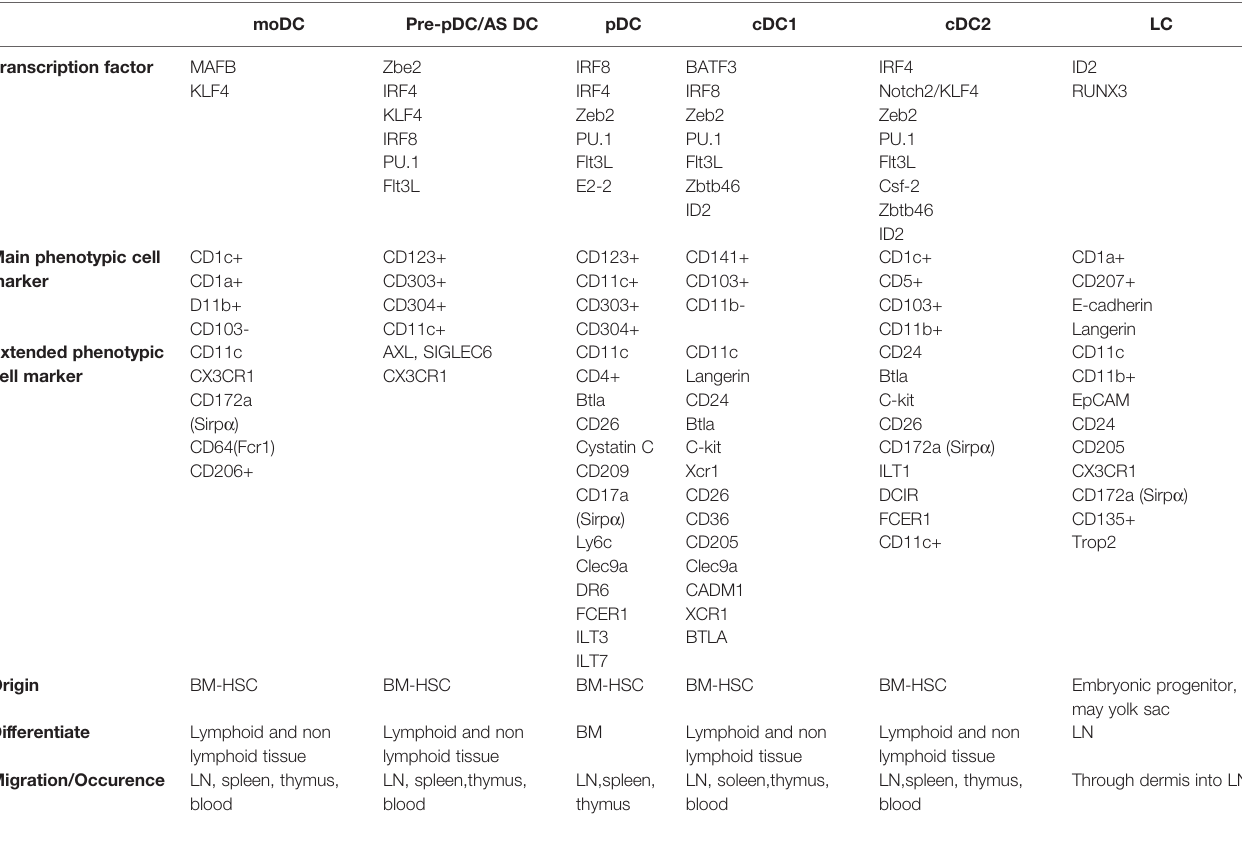
TABLE 1 | Overview of the most important markers of the DC